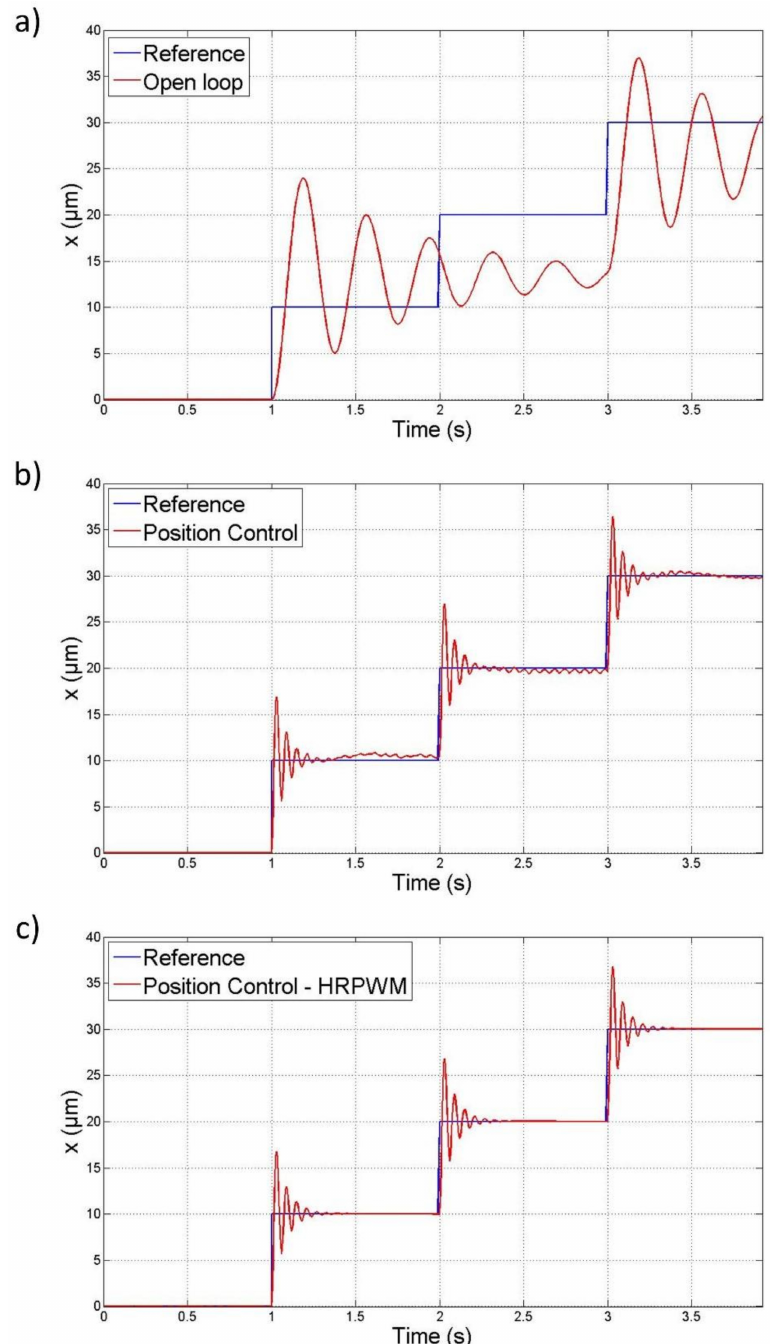
Figure 7. Simulated Response to 10 µ m stair case in open loop ( a ), applying position control ( b ), and applying position control and high resolution pulse width modulation (HRPWM) function ( c